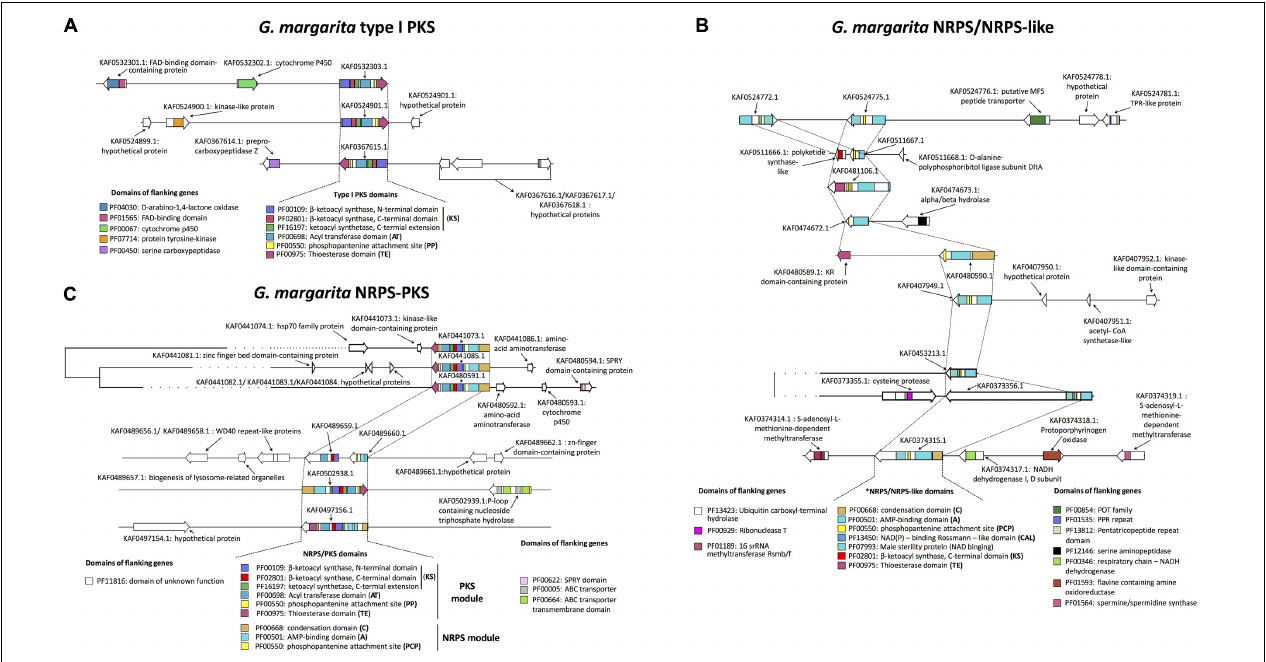
FIGURE 1 | Predicted biosynthetic genes for secondary metabolites in G. margarita , including T1PKS (A) , NRPS/NRPS-like (B) , and hybrid NRPS-PKS (C) . A genomic window is shown for each gene according to the antiSMASH v.5 output (Blin et al., 2019), including flanking genes and their annotations (Venice et al., 2020). Core biosynthetic genes are connected by dashed lines, and a prediction of PFAM functional domains (shown in the legends) has been carried out with BIG-SCAPE (Navarro-Muñoz et al., 2020). Based on the BIG-SCAPE pipeline, some biosynthetic genes (AF0453213.1, KAF0373356.1, KAF0441073.1, KAF0441085.1, and KAF0480591.1) and their surroundings were clustered together due to > 45% sequence